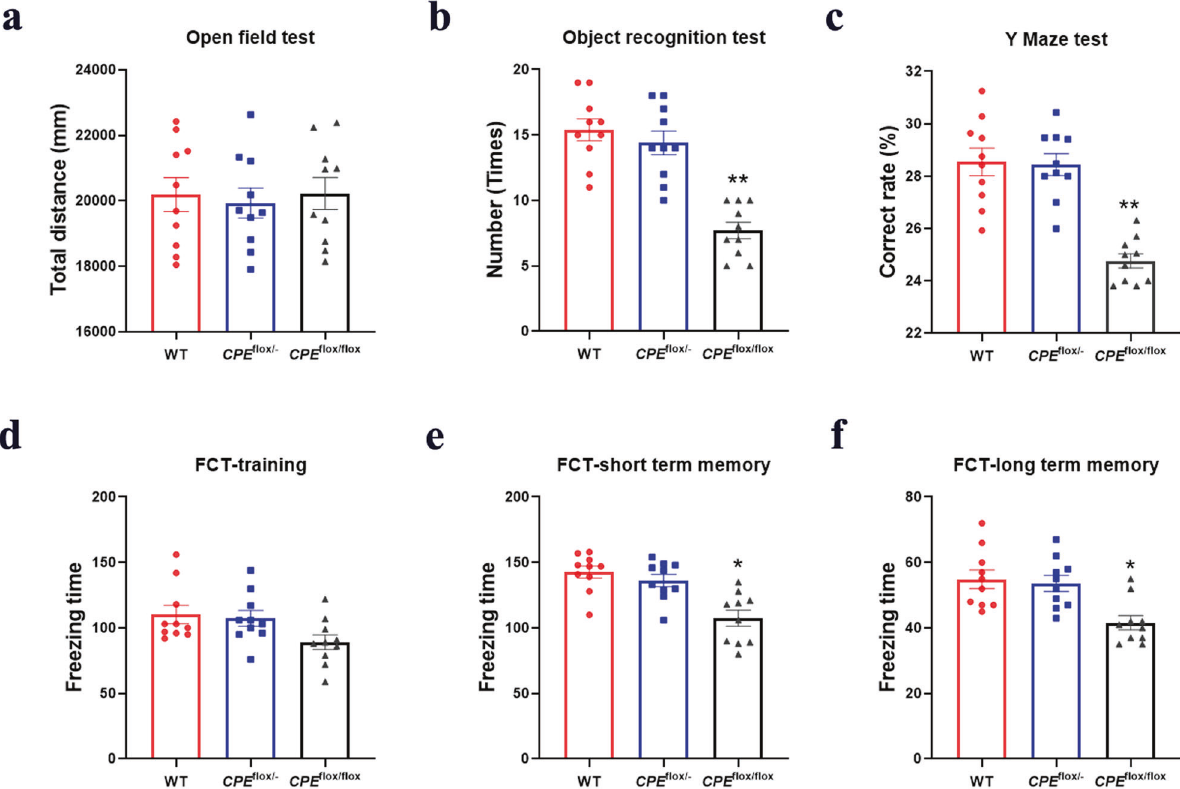
Fig. 2 CPE fl ox/ fl ox mice show impaired learning and memory. Behavioral tests of WT, CPE fl ox/- , and CPE fl ox/ fl ox mice in a open fi eld, b object recognition, c Y maze, and ( d – f ) fear conditioning tests. n = 10 from each group; * P < 0.05 and ** P < 0.01 compared with WT; values are mean ± SEM.